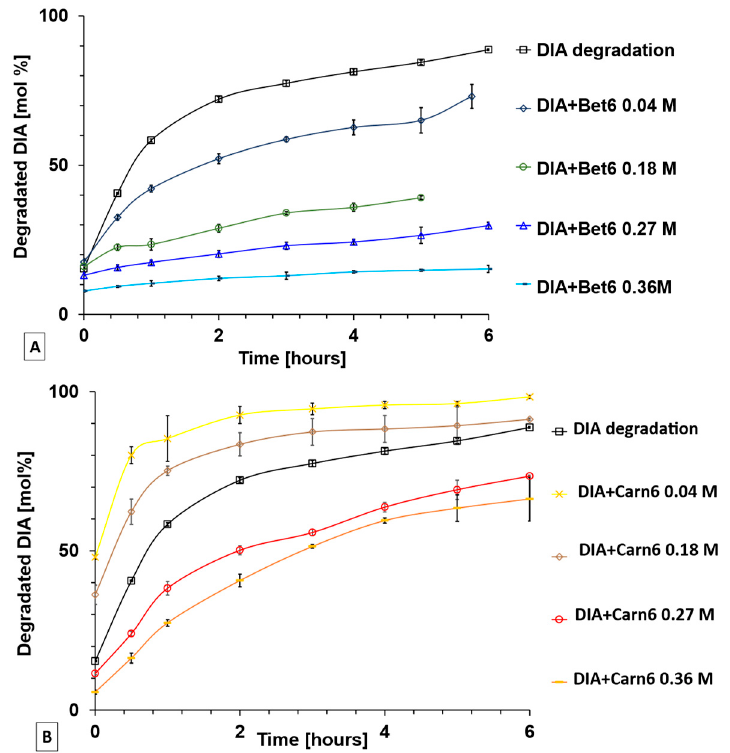
Figure 4. Effects of ILs in slowing down the degradation of DIA under simulated physiological conditions: ( A ) Bet6 solutions; ( B ) Carn6 solutions. Degradation of DIA is expressed in mol% and corresponds to the formation of Rhe. IL concentrations higher than 0.23 M (CAC) contain IL nanoaggregates. Each point is the mean ± SD of three values.